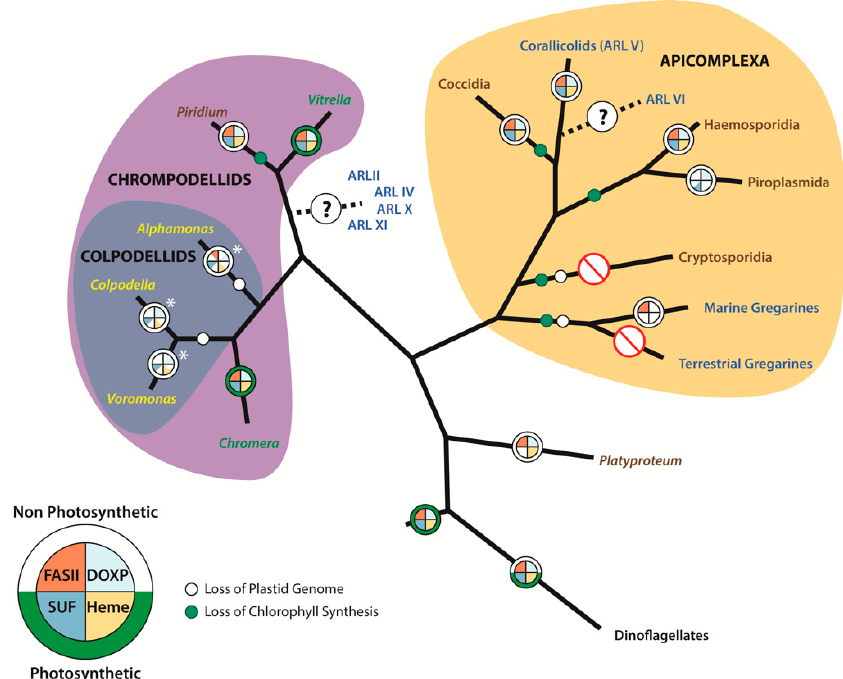
Figure 1. Phylogeny of the Apicomplexa and their close relatives representing the evolutionary history of their plastids and transitions in their nutrient acquisition strategies. Taxa labeled in brown are parasitic, yellow are free-living heterotrophs, green are autotrophic, and the nutritional strategies of taxa labeled in blue remain unclear. Plastid metabolic capacity is represented as a pie chart, with the Type II fatty acid synthesis pathway being represented in orange, the MEP/DOXP pathway represented in light blue, heme synthesis in gold, and the SUF pathway in dark blue; sections left white are missing from the plastid metabolism in the lineage. The ring around the metabolism pie chart is green if the lineage is photosynthetic, or white if non-photosynthetic. White circles on branches indicate the loss of a plastid genome, and green circles indicate the loss of chlorophyll biosynthesis. The asterisk next to Colpodellid plastid diagrams represents the current uncertainty regarding the presence of a plastid in these taxa.